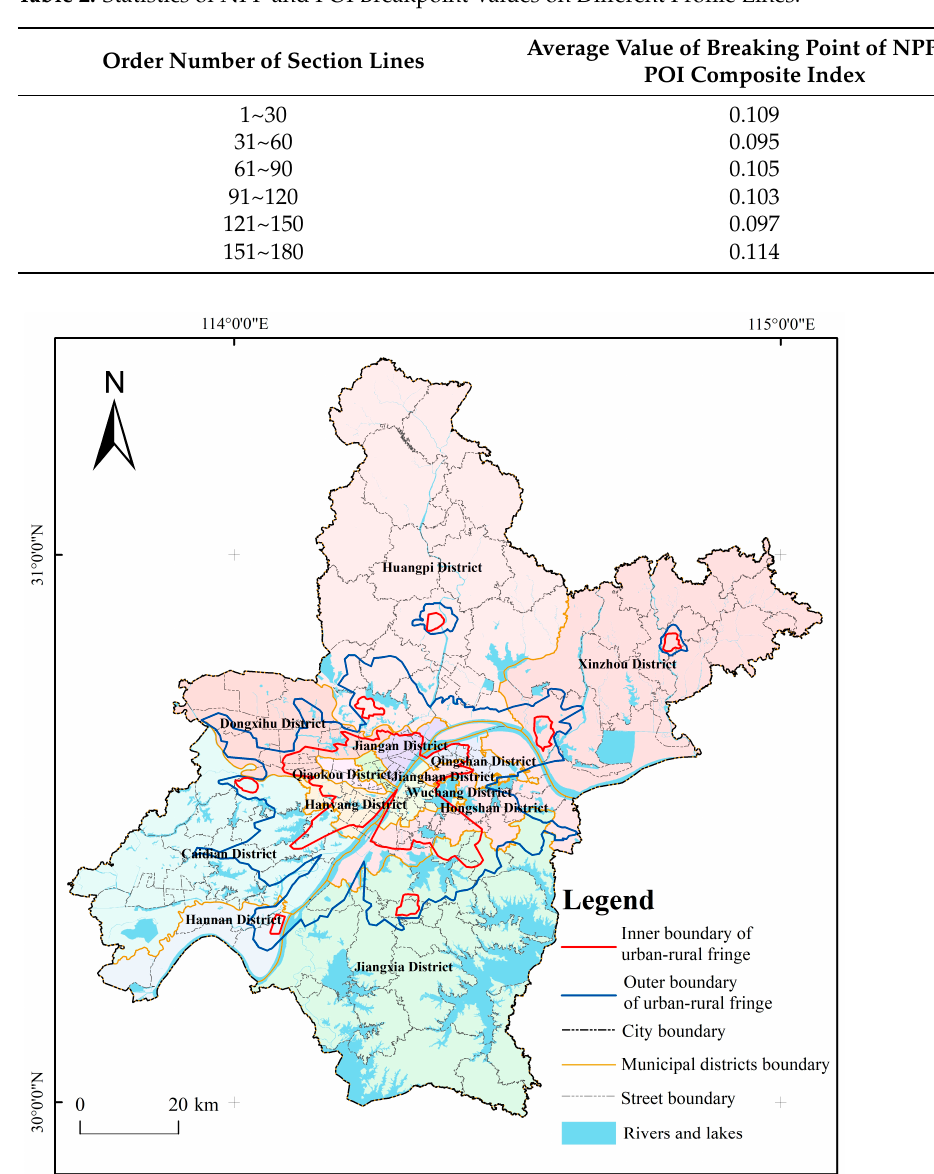
Table 2. Statistics of NPP and POI Breakpoint Values on Different Profile Lines. Order Number of Section Lines